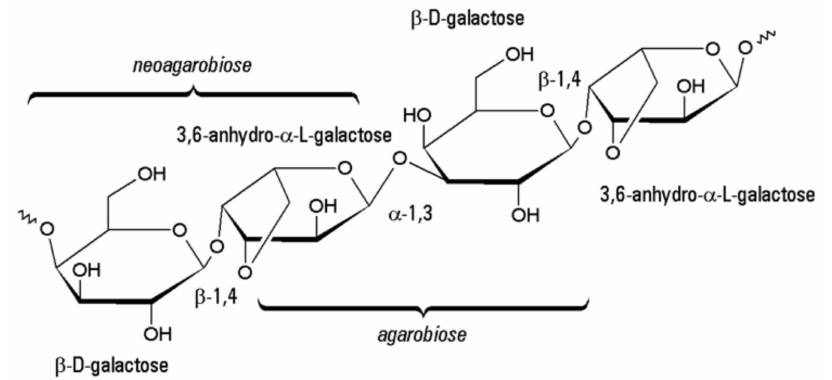
Figure 7. Structure of